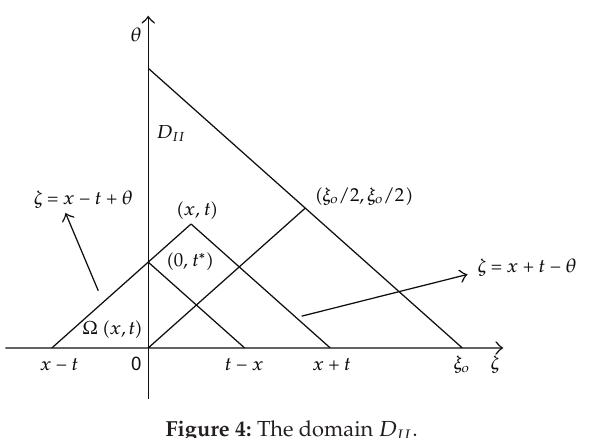
Figure 4: The domain D II